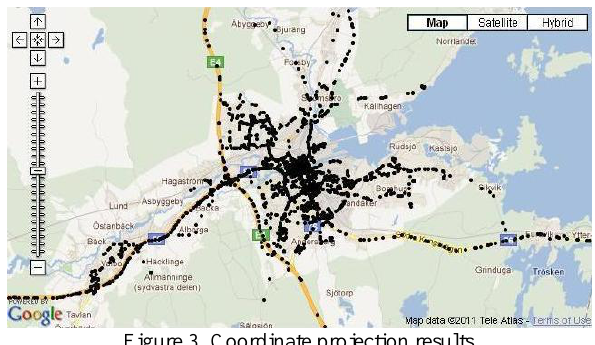
Figure 3. Coordinate projection